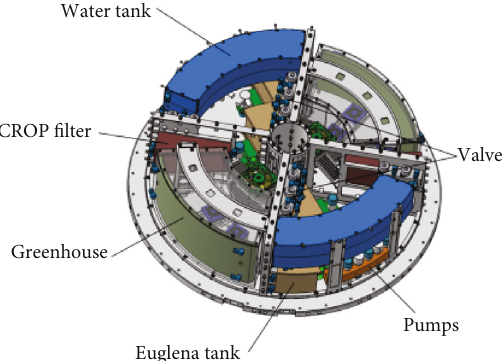
Figure 1: Eu:CROPIS primary payload